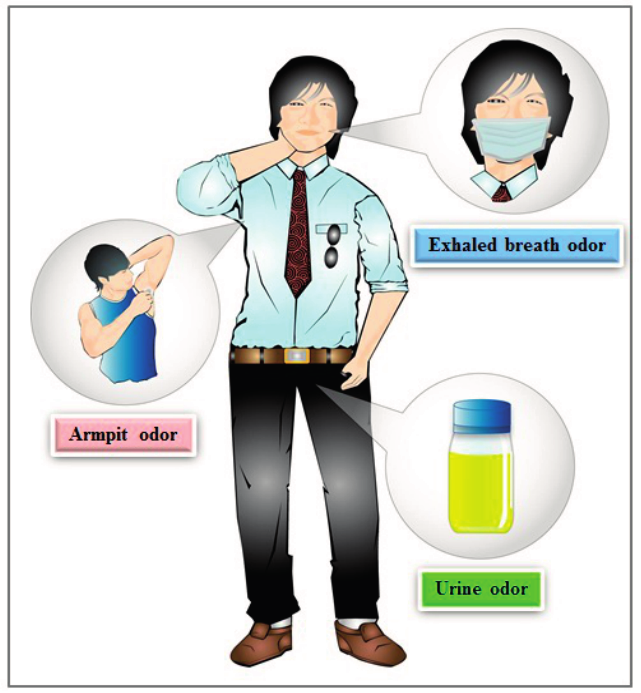
Figure 3. Body odor collection from volunteers for